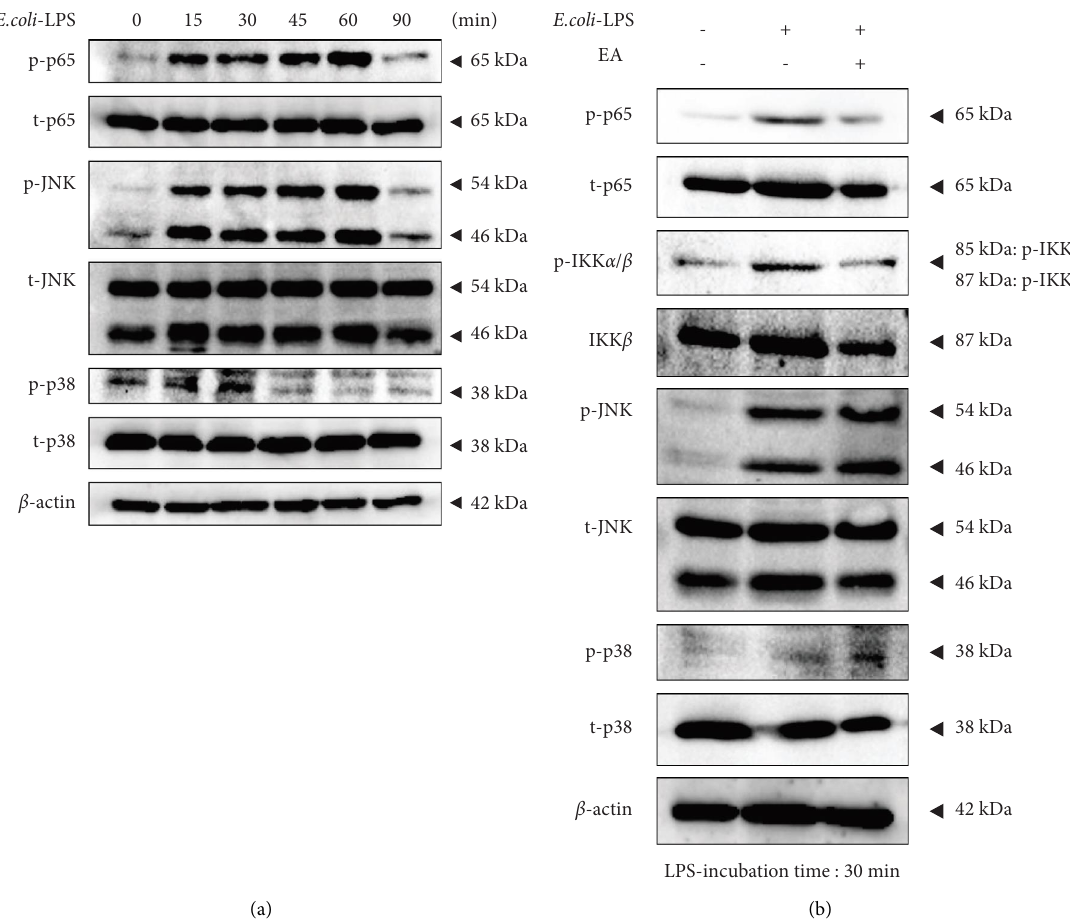
Figure 4: Efects of EA on the LPS induced NF- κ B and MAPKs’ signaling pathway in ST2. (a) E. coli -LPS (1 μ g/mL) is applied to ST2 cells and collected at several time points. NF- κ B p65 and MAPKs (JNK and p38) in ST2 cells are analyzed by Western blotting. β -actin is used as a loading control. (b) EA: Equisetum arvense extract (3 μ g/mL) is pretreated in ST2 cells for 30minutes, and then E . coli -LPS (1 μ g/mL) is additionally applied to ST2 cells. IKK α / β , NF- κ B p65, and MAPKs (JNK and p38) in ST2 cells are assessed at 30minutes by Western blotting. β -actin is used as the loading control.